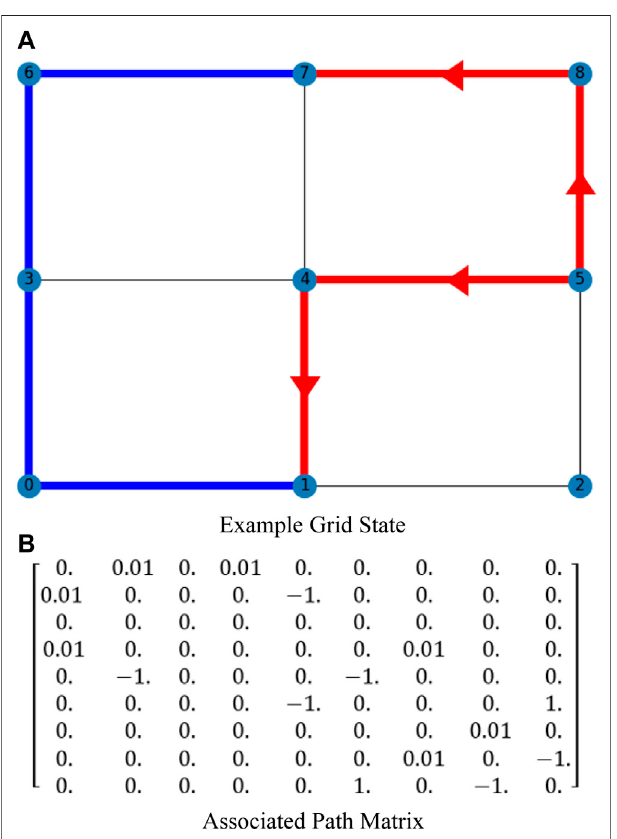
FIGURE 9 | Example grid state and path matrix. (A) Example grid state. (B) Associated path matrix.